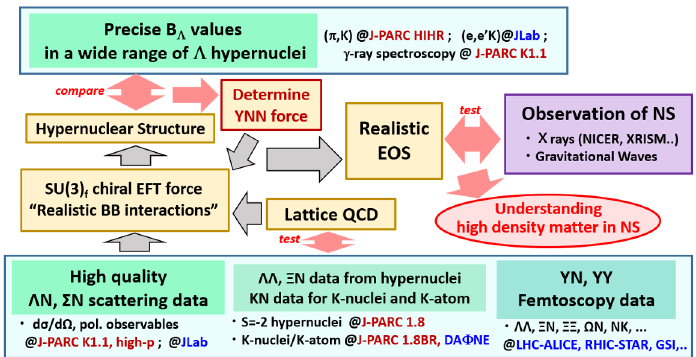
Figure 2. Scenario to solve the hyperon puzzle in the J-PARC Hadron Facility extension